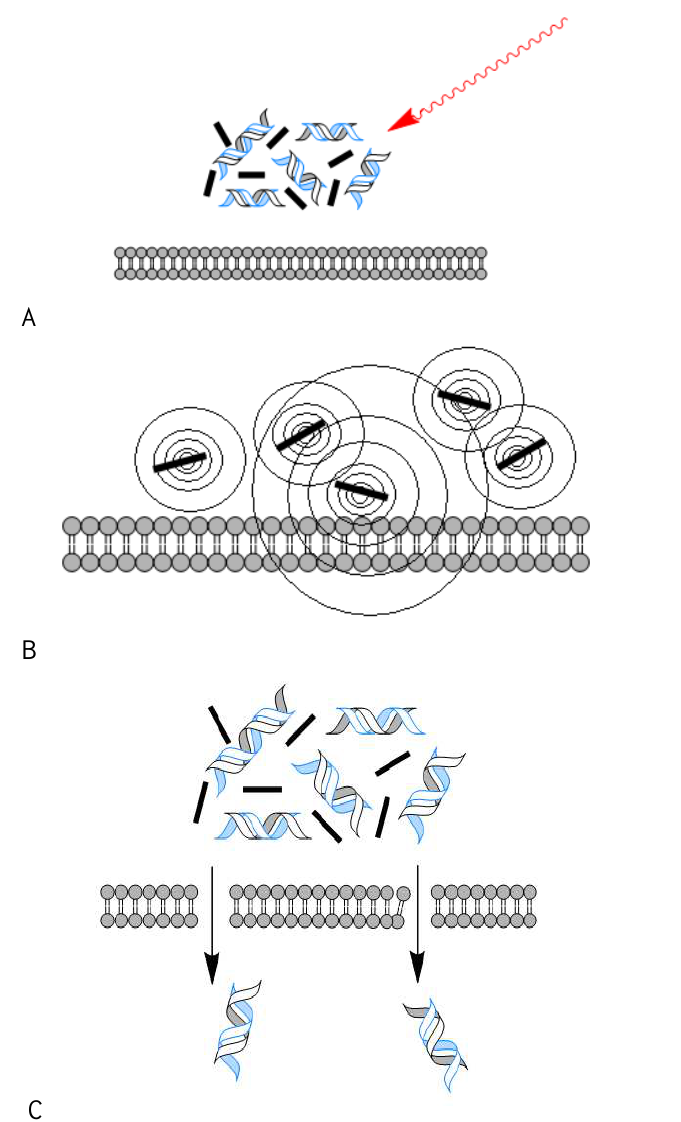
Figure 1. Laser activation of carbon black creates membrane perforation. ( A ) Femtosecond laser pulses applied to cells incubated with foreign DNA/carbon black. ( B ) Laser activation generates small acoustic shock-waves which disrupt the cellular membrane and create holes. ( C ) DNA is now able to traverse the cell